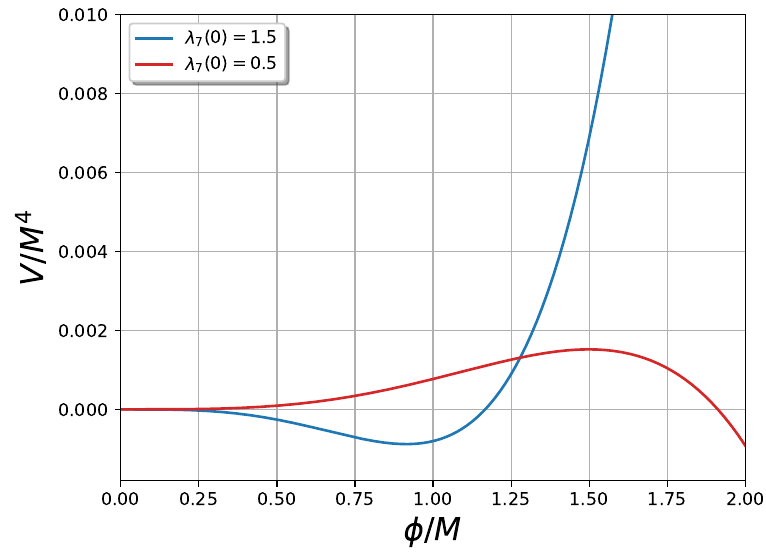
Figure 4 . Zero temperature effective potential at one-loop for two different values of singlet- η coupling λ 7 , considering the singlet-RHN Yukawa coupling Y 0 (0) = 0 . 8